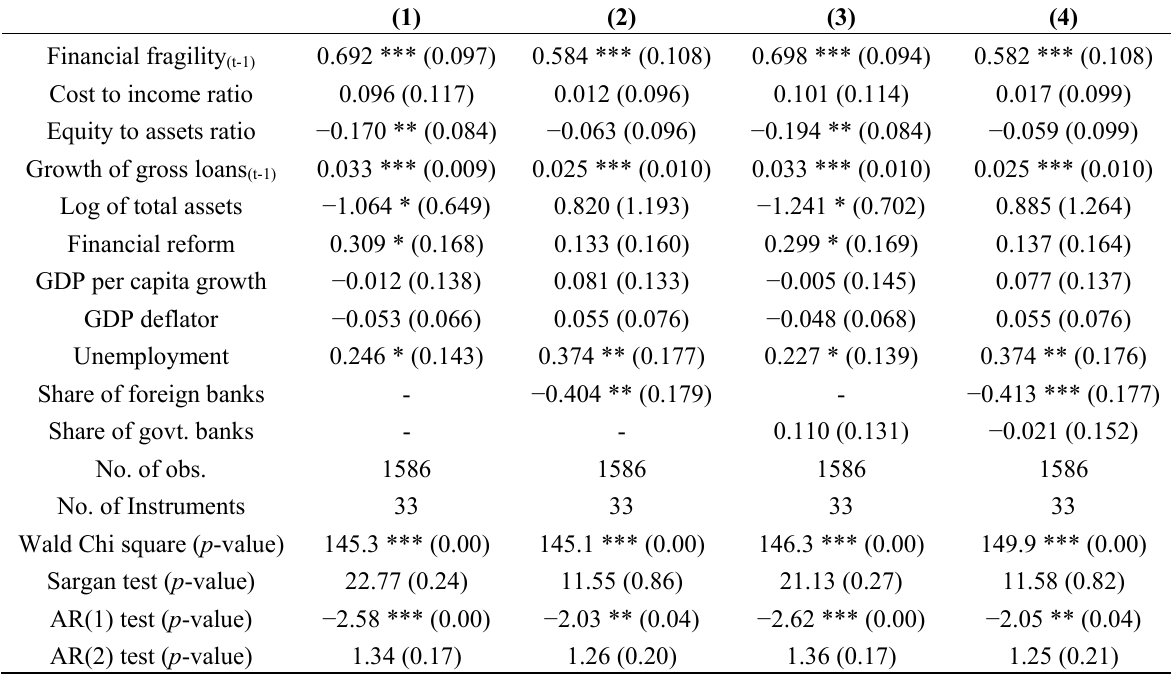
Table 4. Dynamic panel estimation of financial fragility with financial